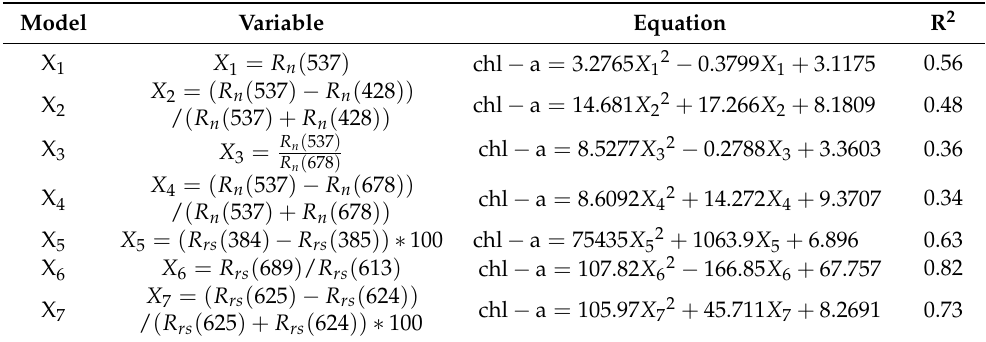
Figure 3. Correlation coefficient between single-band remote sensing reflectance and in situ chl-a concentration. Table 3. The optimal fitting equation between reflectance and chl-a concentration based on regres- sion